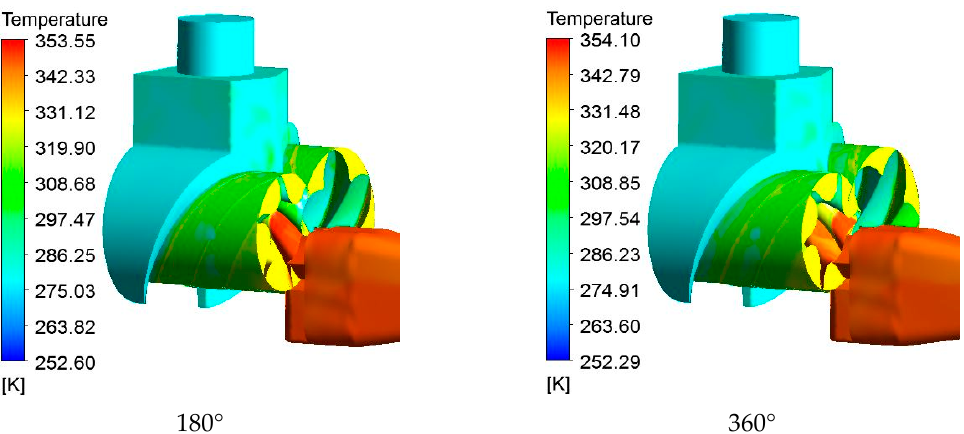
Figure 10. The temperature distribution inside the compressor at different angles.